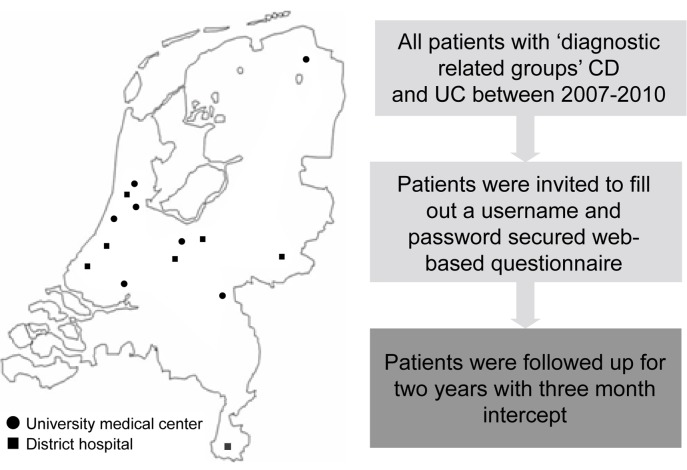
Design of the COIN study.